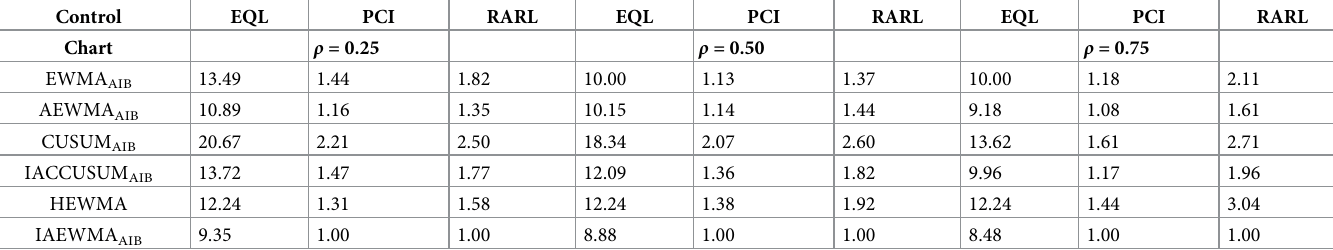
Table 5. Overall performance measures of the existing and proposed IAEWMA AIB control charts at different values of ρ .